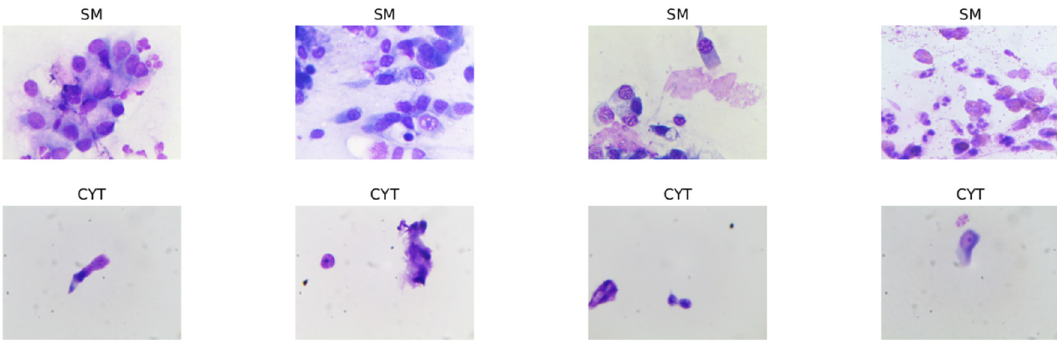
Figure 13. Some examples of SM and CYT fields.